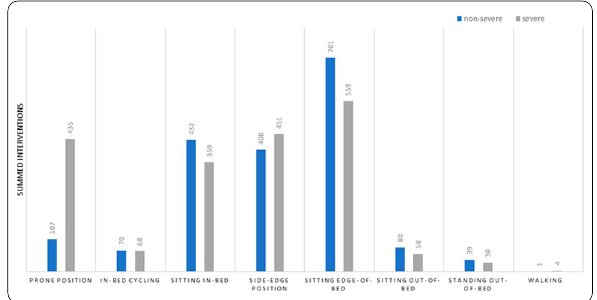
Fig. 1 Summed proning, rehabilitation interventions and mobilizations according to